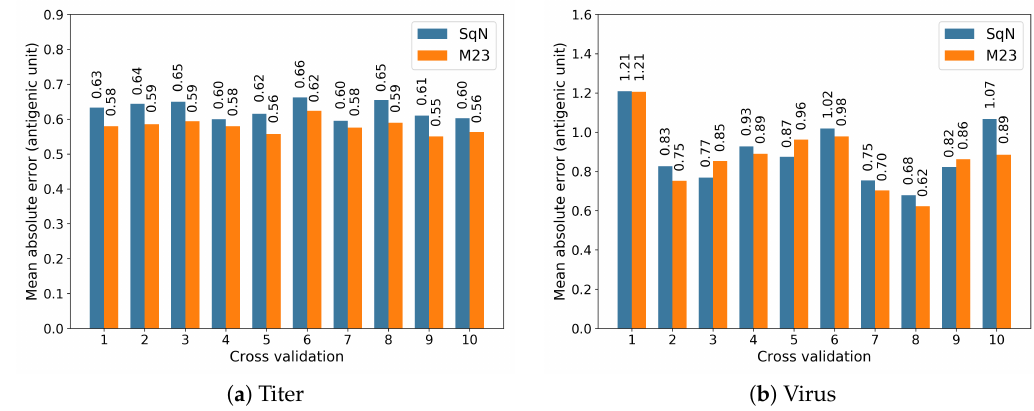
Figure 13. The results of 10-fold cross-validation for models M23 and SqueezeNet.